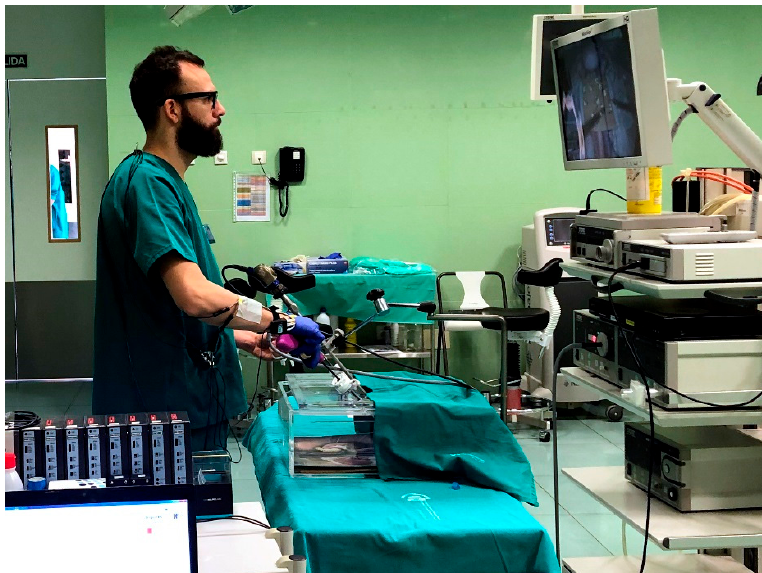
Figure 4. Setup of the study. A surgeon is performing the transfer task using an instrument handle with a size L.